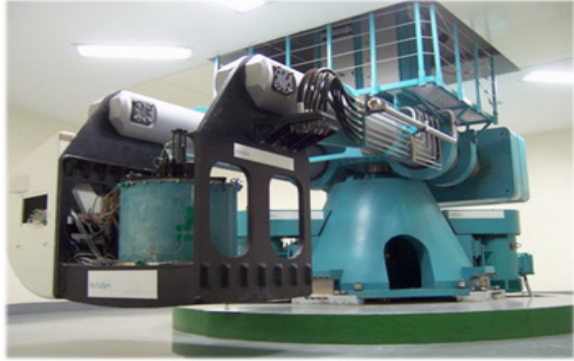
Fig. 1. Centrifugal model test apparatus (KOCED Geocentrifuge center at KAIST)